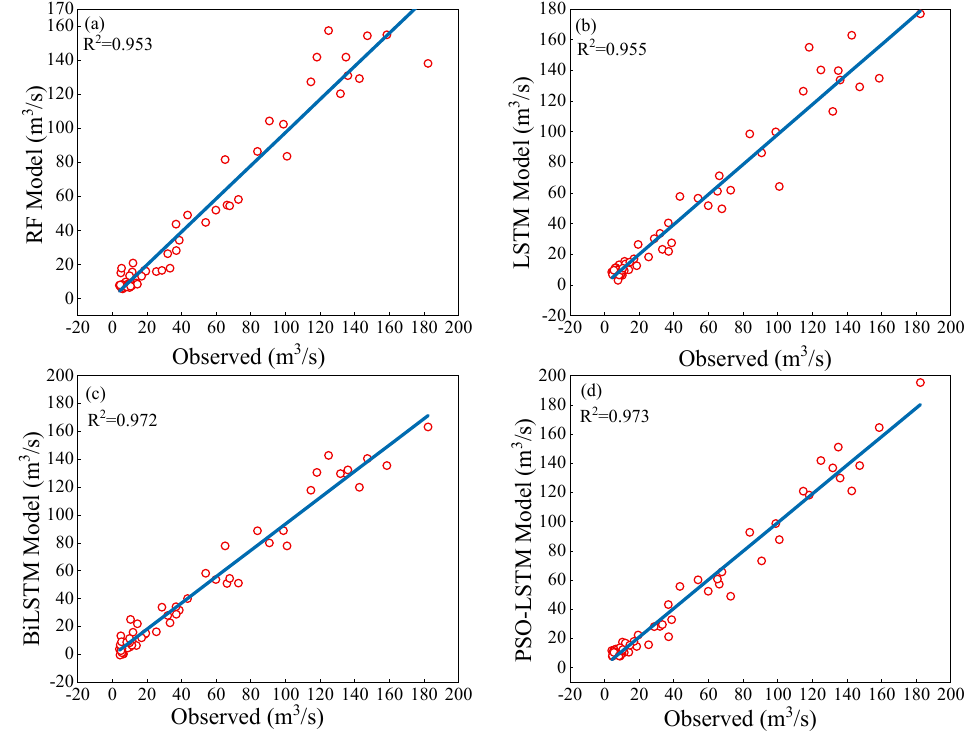
Figure 6. Scatter plots and fitting lines of simulated and observed monthly average runoff for the four models during the test period, with R 2 representing the coefficient of determination. ( a ) RF model; ( b ) LSTM model; ( c ) BiLSTM model; ( d ) PSO-LSTM model. Table 3. Evaluation results of the RF, LSTM, BiLSTM and PSO-LSTM models in monthly average runoff simulation during the training period (1990-2010) and testing period (2011-2015) in the mu- zati river basins.